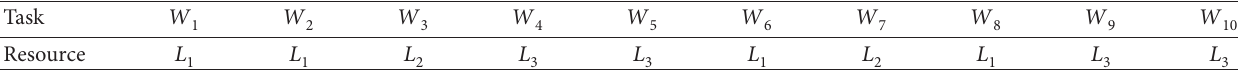
A LGORITHM 2: Function Reallocate. Table 6: Resource-task assignment of P .